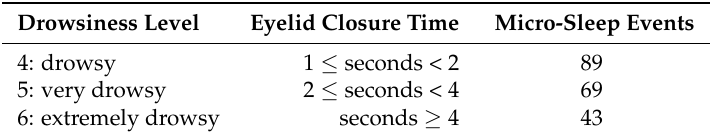
Table 2. Categorization and allocation of the 201 detected micro-sleep events to the corresponding level of drowsiness based on the eyelid closure time.